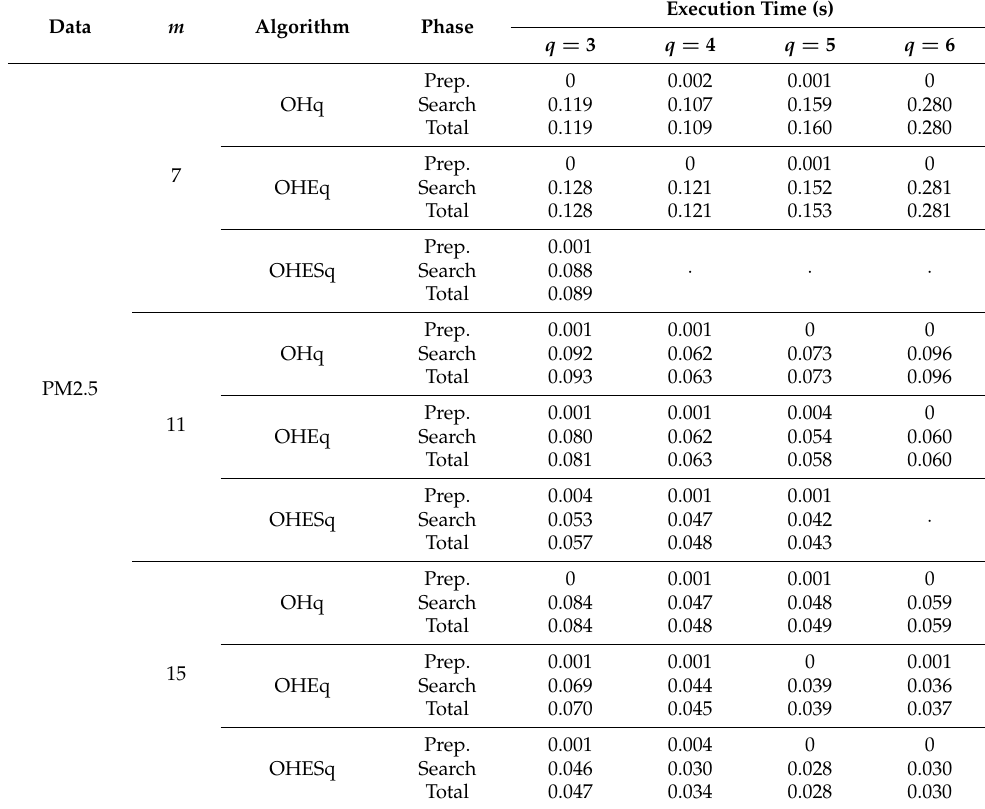
Table A2. Execution times of 1000 patterns for PM2.5 data.